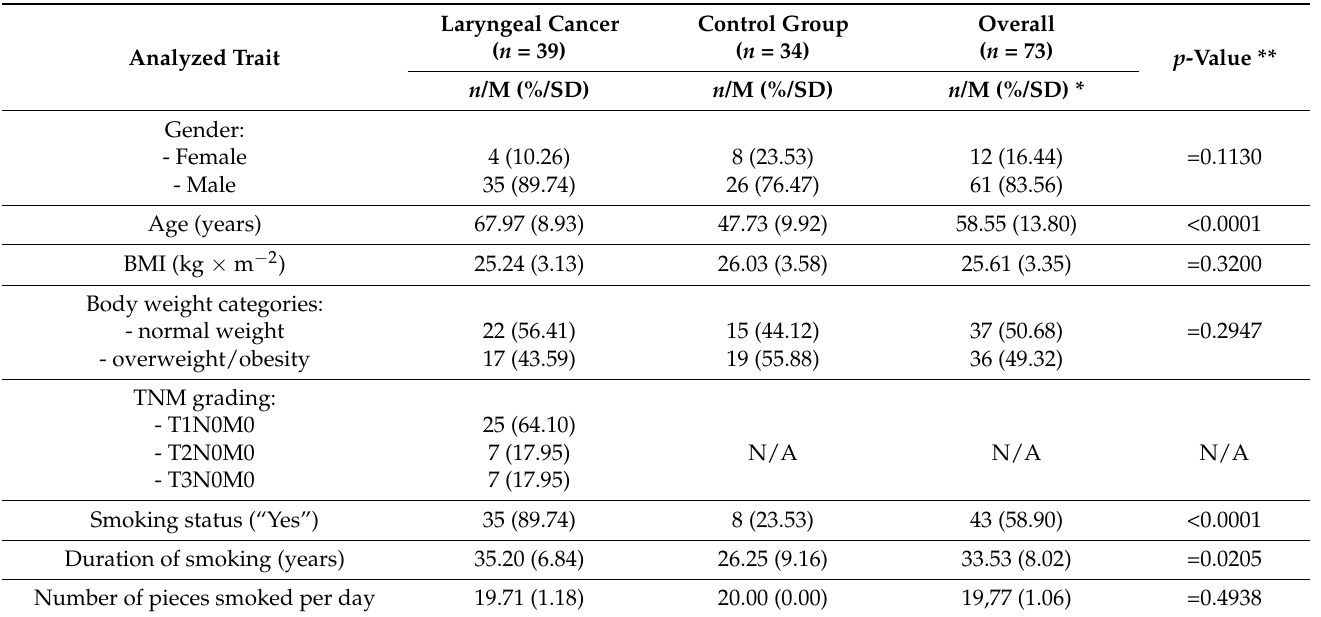
Table 1. Baseline characteristics of the study cohort and study